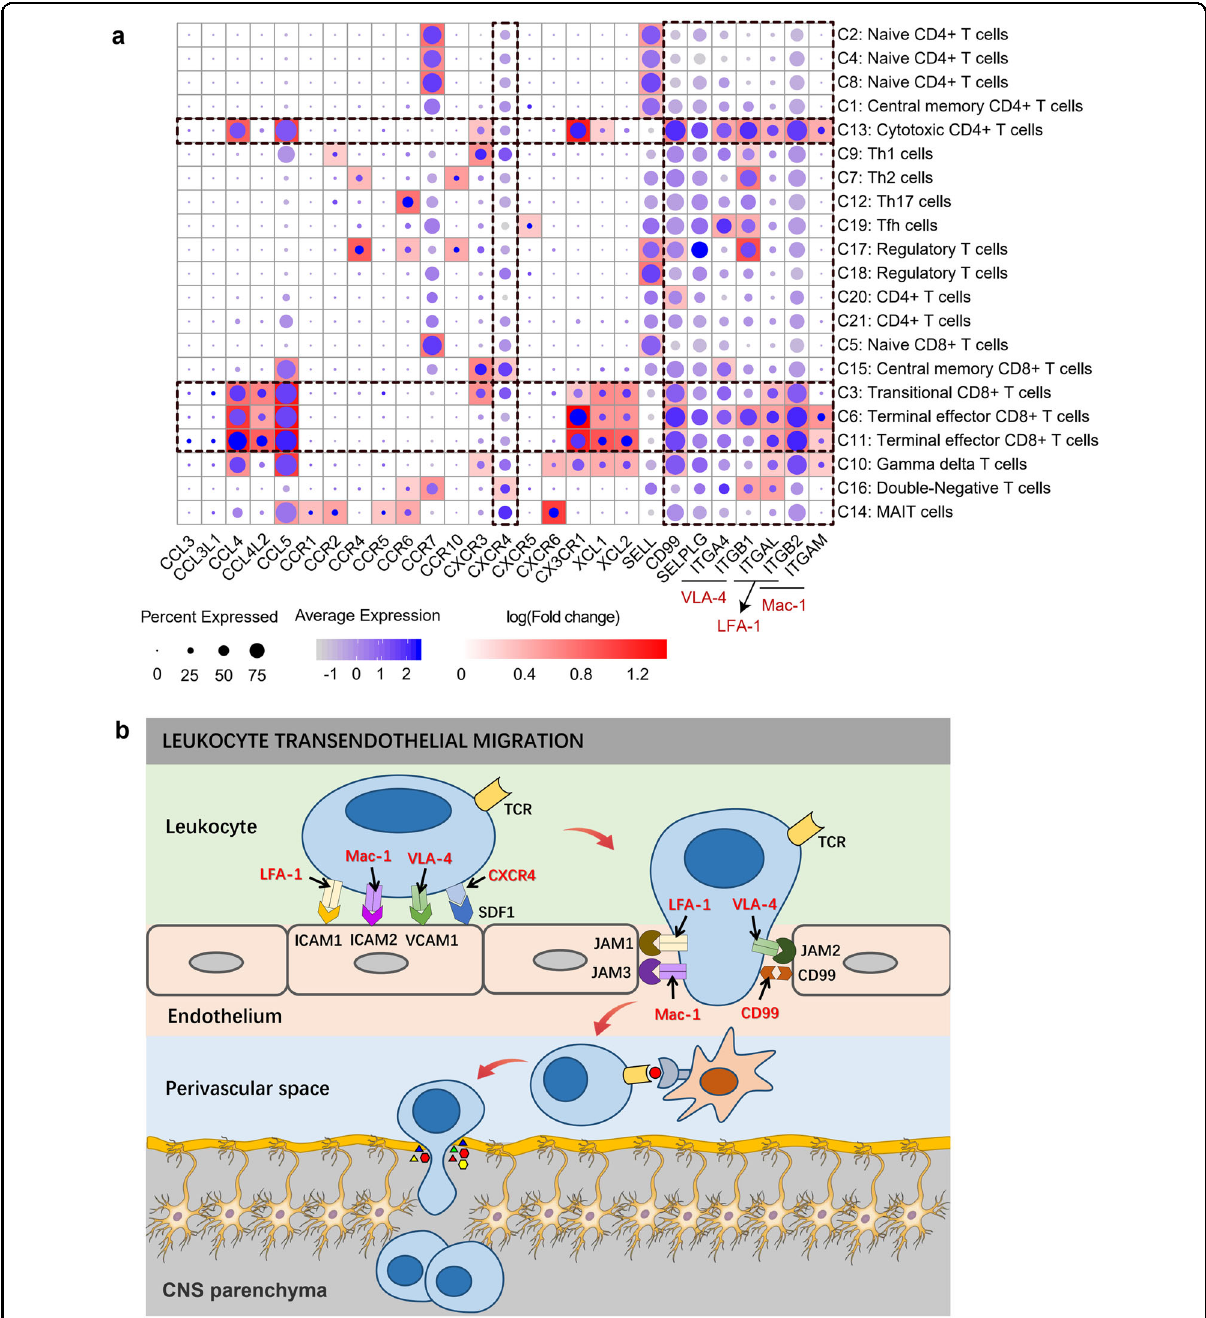
Fig. 6 Cell migration and adhesion-related genes may be involved in lymphocytes penetrating the BBB in the PD. a A global view of the expression pro fi ling of genes related to cell migration and adhesion in each cluster. The size of the dot corresponds to the percentage of cells expressing the gene in each cluster, and the color represents the average log normalized gene expression. Background heatmap shows the fold change in gene expression between each cluster and other clusters. Fold change was calculated using the function FindAllMarkers in R package Seurat with default parameters. Only positive markers (logFC > 0) in each cluster are shown in the heatmap. b Possible mechanism of cytotoxic T cells passing through the BBB in PD. Depiction of lymphocyte migration across endothelial cells was based on the leukocyte transendothelial migration pathway (KEGG pathway: hsa04670). During in fl ammation, adhesion molecules, chemokines and their receptors mediate the arrest, polarization, directed crawling and endothelial passage of lymphocytes on endothelial cells. Once T cells cross the BBB endothelium, T cells may recognize their cognate antigens and become reactivated behind the BBB. The ampli fi ed in fl ammatory response leads to parenchymal basement membrane damage. Finally, activated T cells enter the brain parenchyma to participate in central nervous system